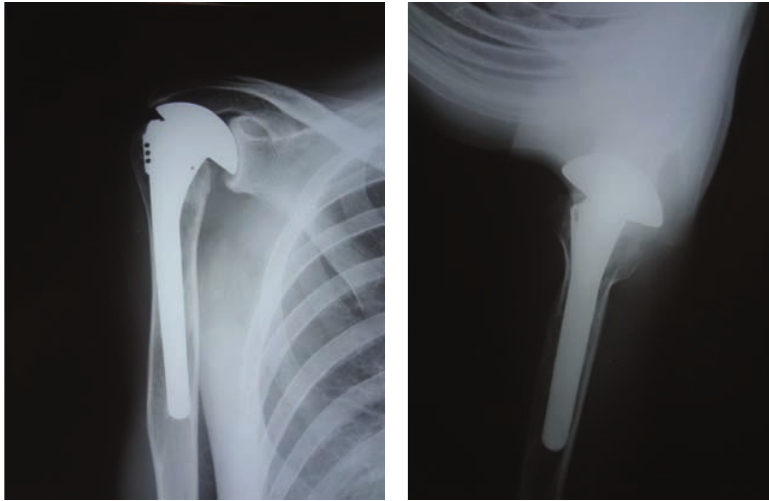
Figure 6: The follow-up radiographs at 60 months